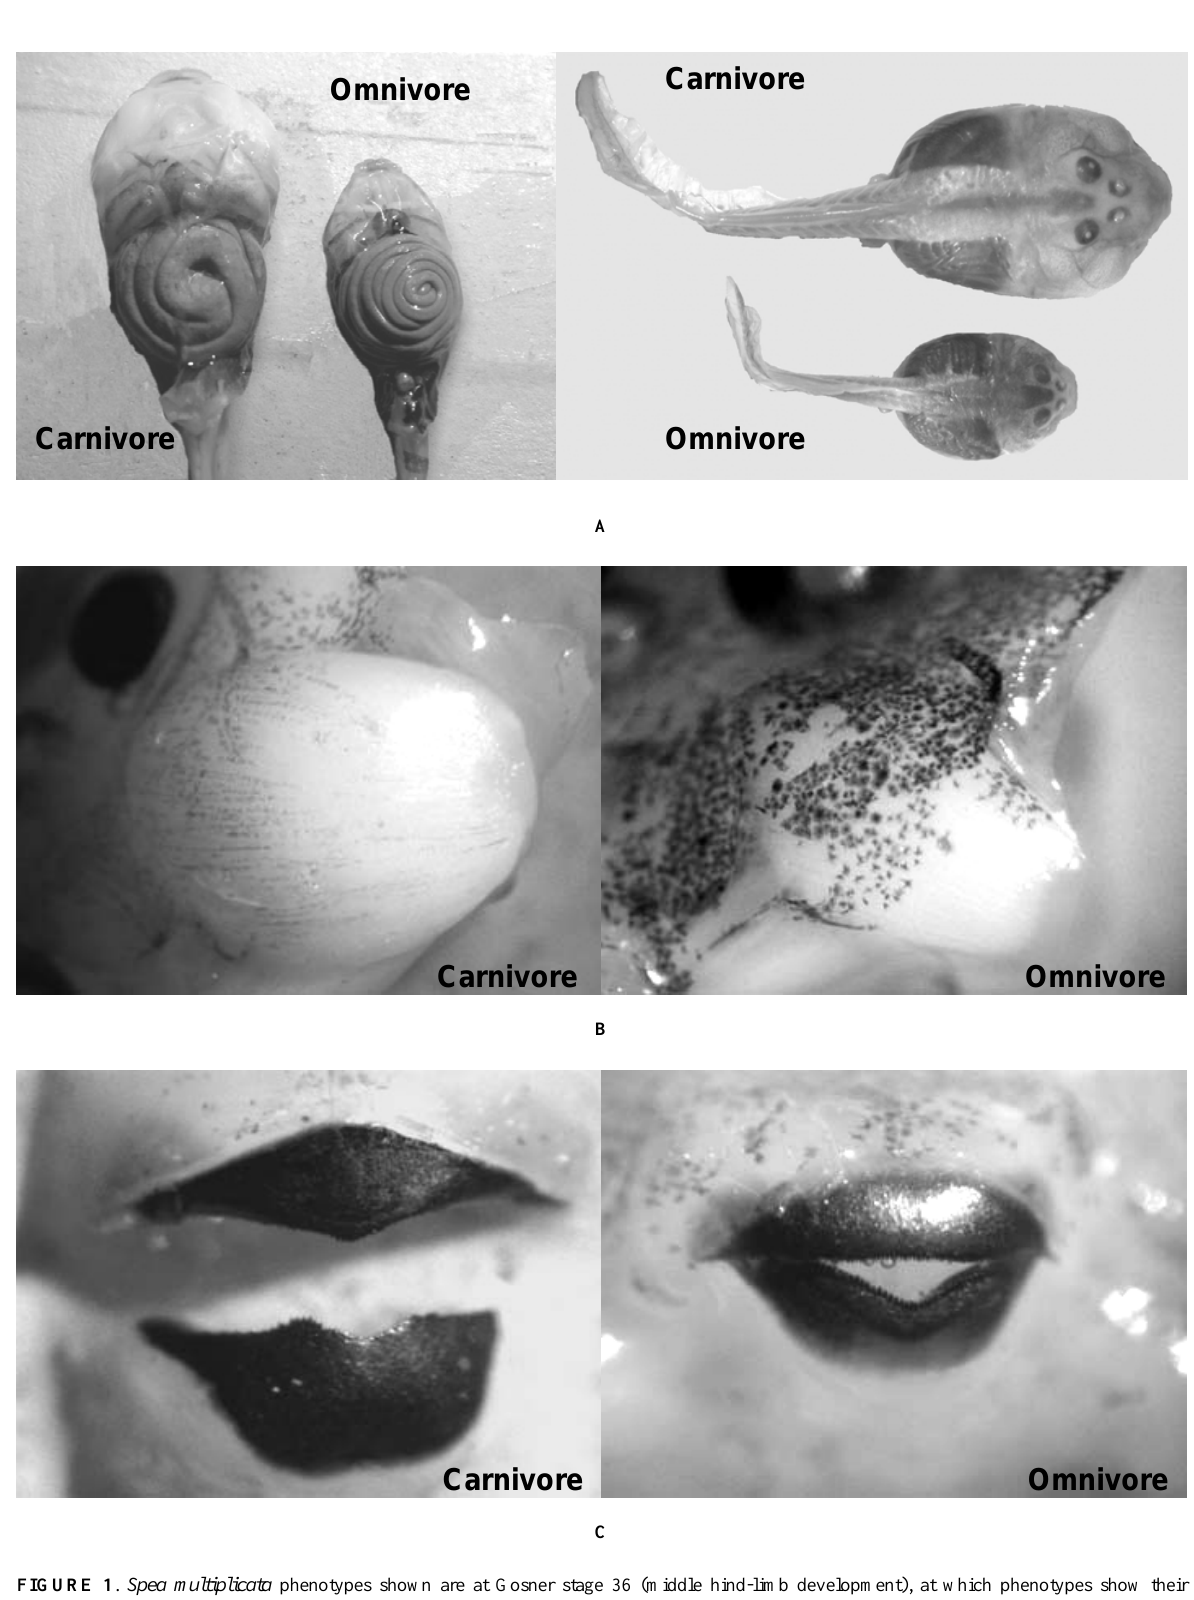
FIGURE 1 . Spea multiplicata phenotypes shown are at Gosner stage 36 (middle hind-limb development), at which phenotypes show their greatest differences in size and morphology. Size and shape differences between the phenotypes are apparent in intestines, jaw musculature, and beak morphology. (A) Carnivores have wider and shorter intestines than do omnivores, (B) carnivore orbitohyoideus jaw muscles show hypertrophy relative to those of omnivores, and (C) carnivores have more sharply pointed beaks than do